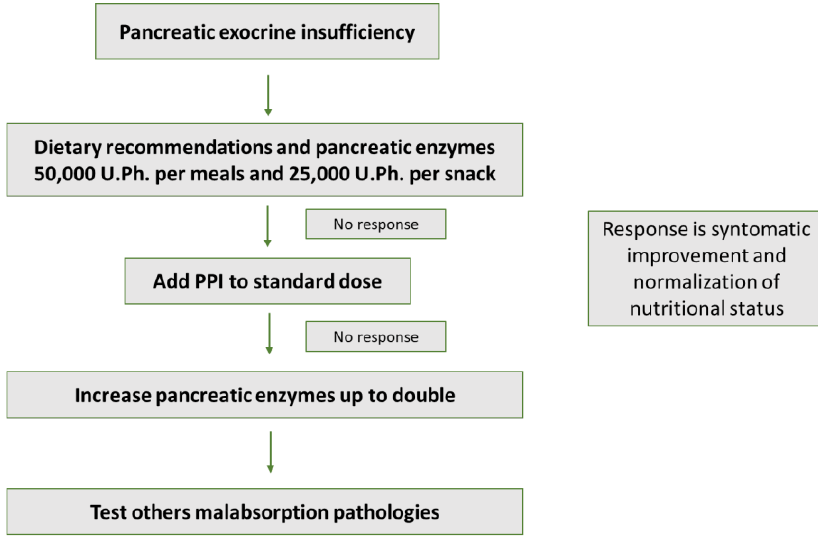
Figure 1. Management of PERT in pancreatic exocrine insufficiency.